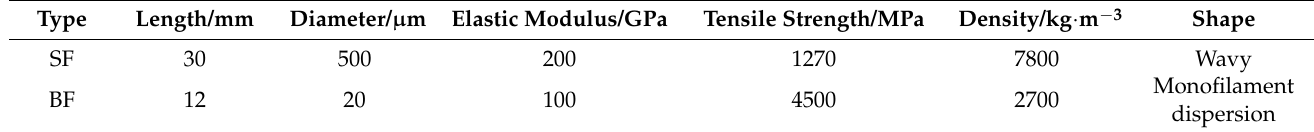
Table 2. Main physical property parameters of fiber.